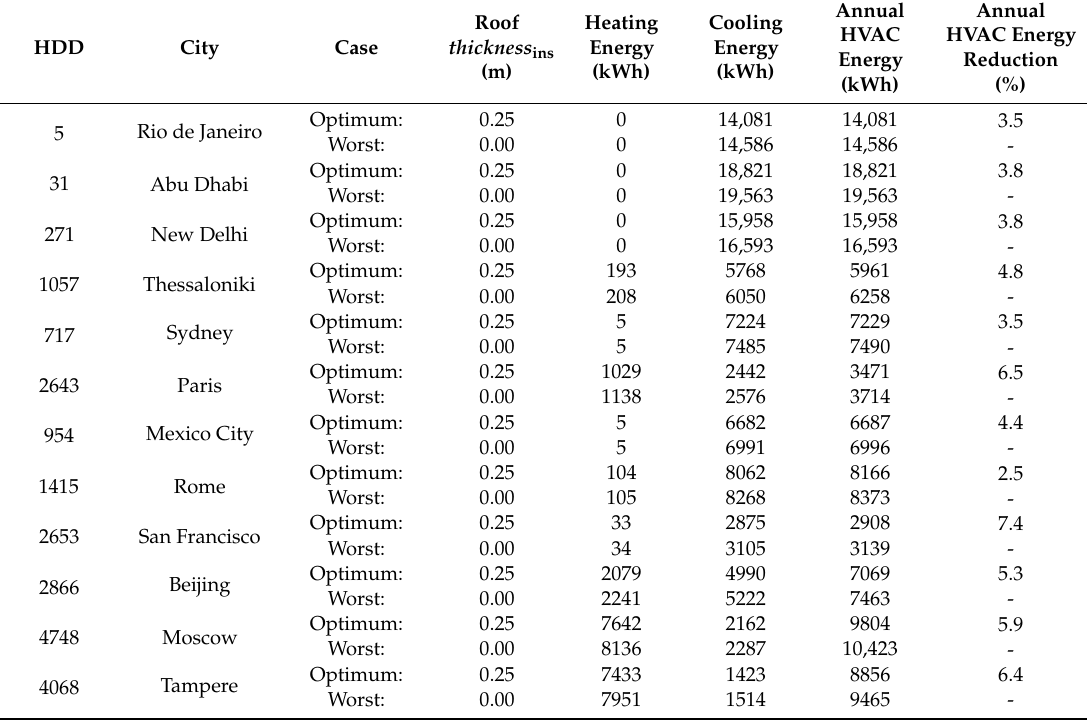
Table 4. Heating, cooling, and annual HVAC energy consumption and energy savings with the optimum roof thermal insulation thickness compared to the worst performing for the case study building with “standard roof” in each climate